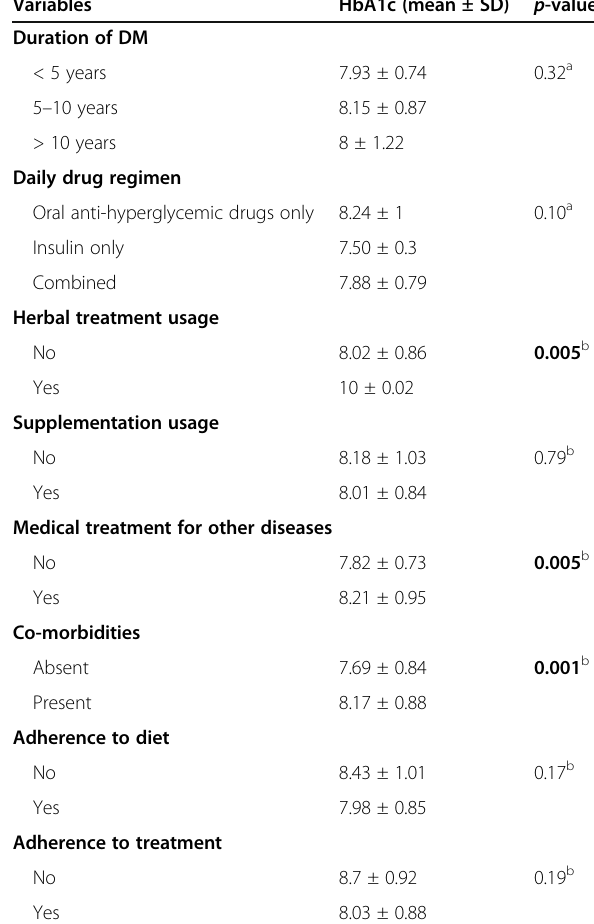
Table 2 Association between medical characteristics of the patients and HbA1c